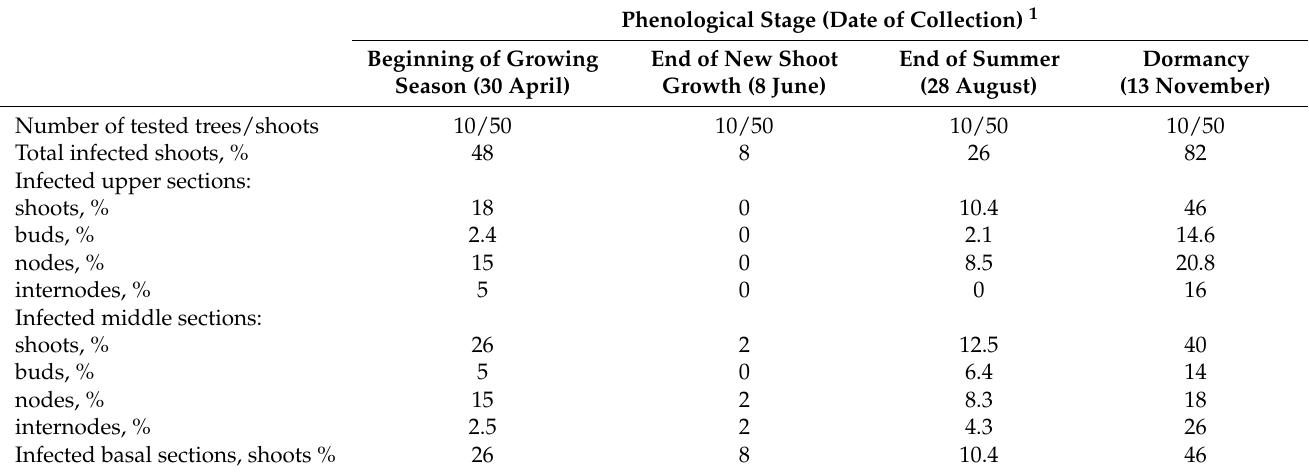
Table 4. Fungal colonization of the Manchurian apricot shoots during the vegetation period of 2015.